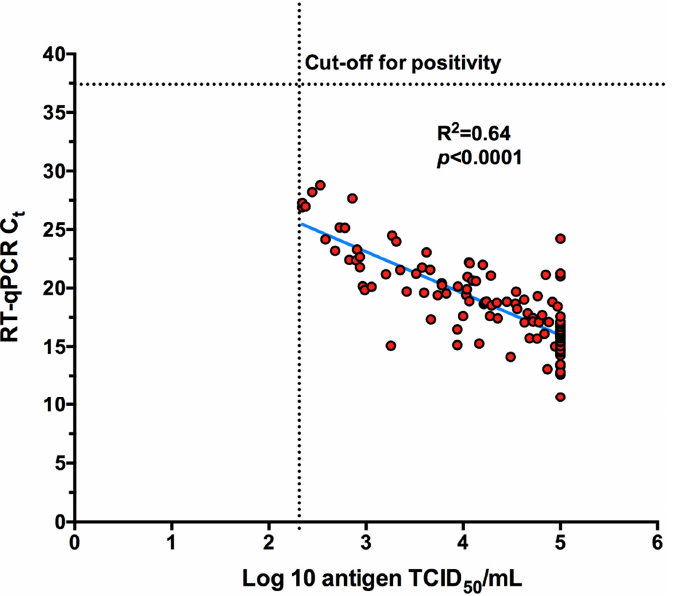
Figure 1. SARS-CoV-2 antigen detection according to RT-qPCR results. ( a ) The level of SARS-CoV-2 Ag among the RT- qPCR positive and negative samples. ( b ) Receiver operating characteristic (ROC) curve analysis to evaluate the diagnostic value of the LIAISON SARS-CoV-2 Ag assay. Data are presented as mean ± SD.